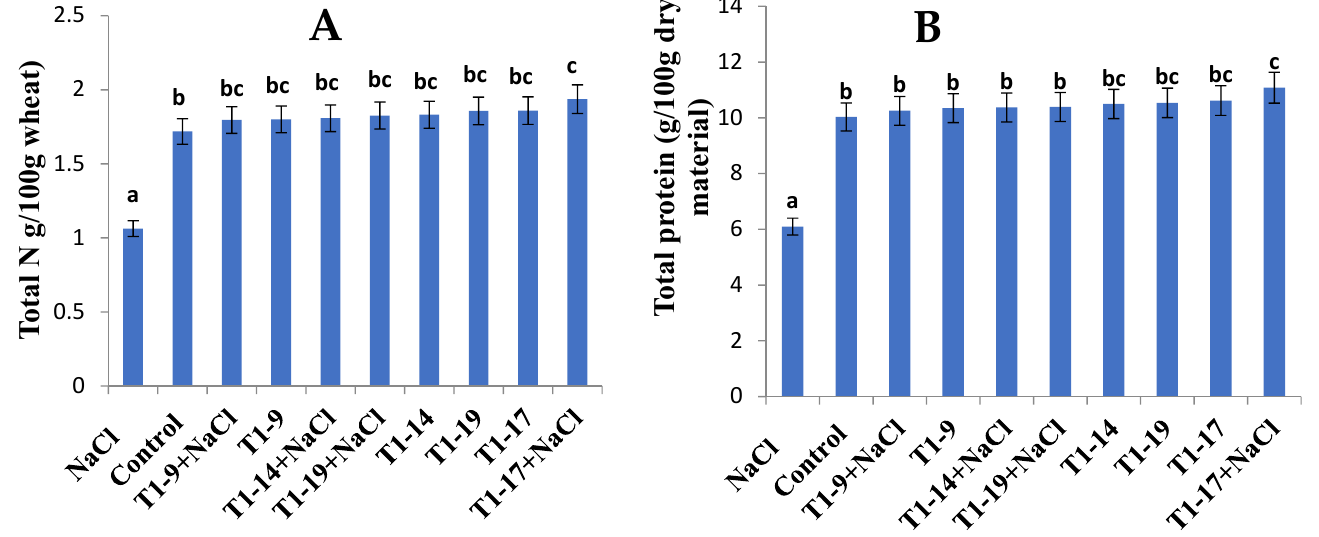
Figure 3. Effect of seed biopriming with PGPB strains on the wheat N-content (g/100 g wheat) ( A ) and the total protein content (g/100 g wheat) ( B ) of durum wheat plants under a different salinity regime. Bars represent the standard error of the mean (SEM). Different letters above the error bars indicate significant difference at p < 0.05. Control, no NaCl and no PGPB; NaCl, no PGPB in salinized soil; T1, bioprimed seed; 9, Bacillus pumilus MA9; 14, Virgibacillus halodenitrificans MA14; 17, Bacillus subtilis MA17; 19, Bacillus safensis MA19.